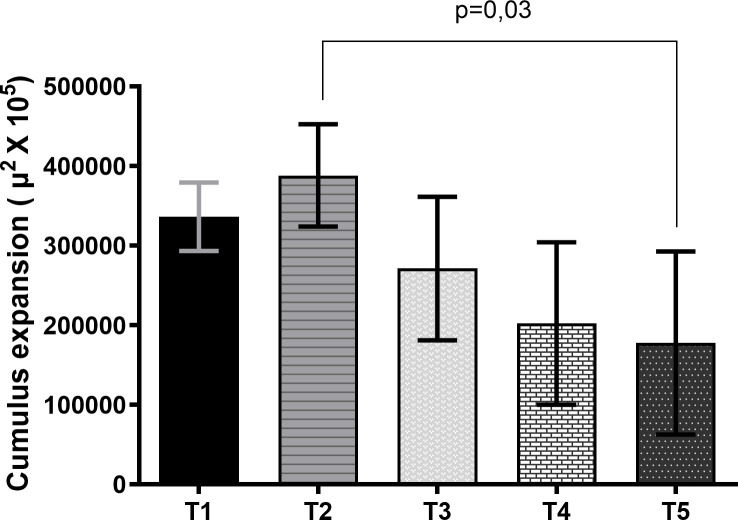
Expansion area of cumulus-oocyte complexes submitted to maturation (IVM) for 22 h (T1), pre-maturation (PIVM) for 6 h plus IVM for 22 h (T2), PIVM with scriptaid for 6 h plus IVM 22 h (T3), PIVM for 6 h plus IVM with scriptaid for 22 h (T4), PIVM for 6 h with scriptaid plus IVM 22 h with scriptaid (T5).Data are expressed as mean ± standard deviation and were analyzed by ANOVA and then compared by the Tukey test at the 0.05 level of significance. The data were obtained from the value of the initial mean area (0 hour) of the cumulus-oocyte-complexes (CCOs) subtracted from the value of the final mean area of the CCOs after IVM (22 h).